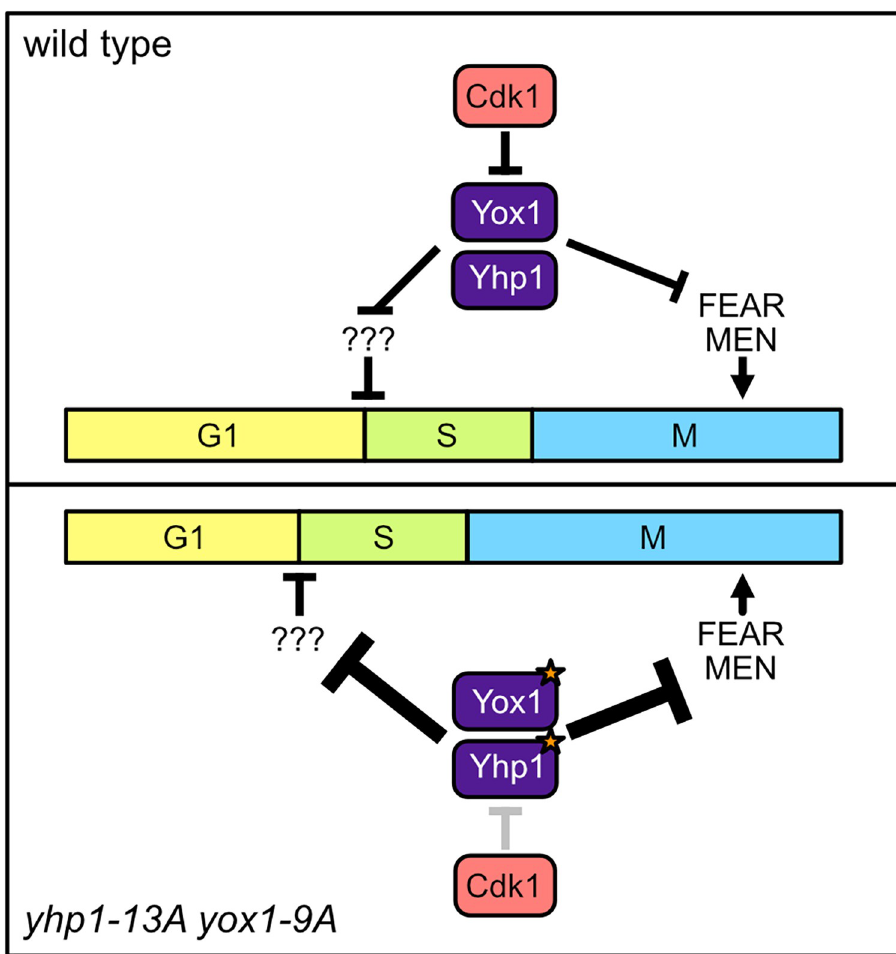
Fig 7. Model of cell cycle regulation by Yox1 and